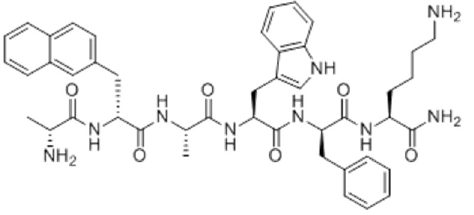
Figure 18. Chemical structure of GHRP-2. Formula: C 45 H 55 N 9 O 6.